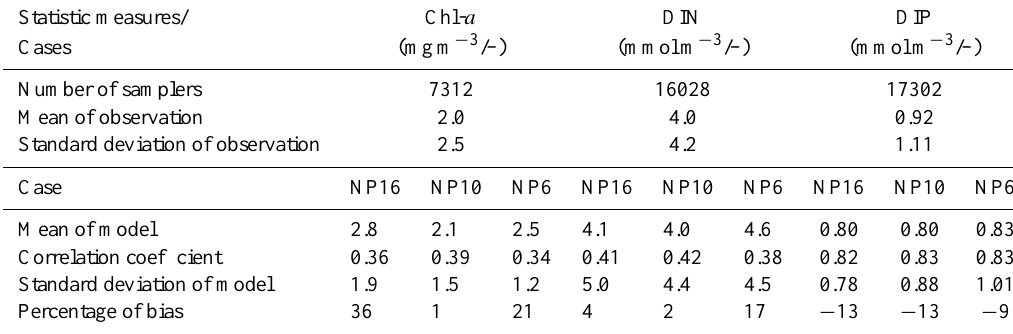
Table 3. Statistic comparison between modeled results and observed data for the whole Baltic Sea.